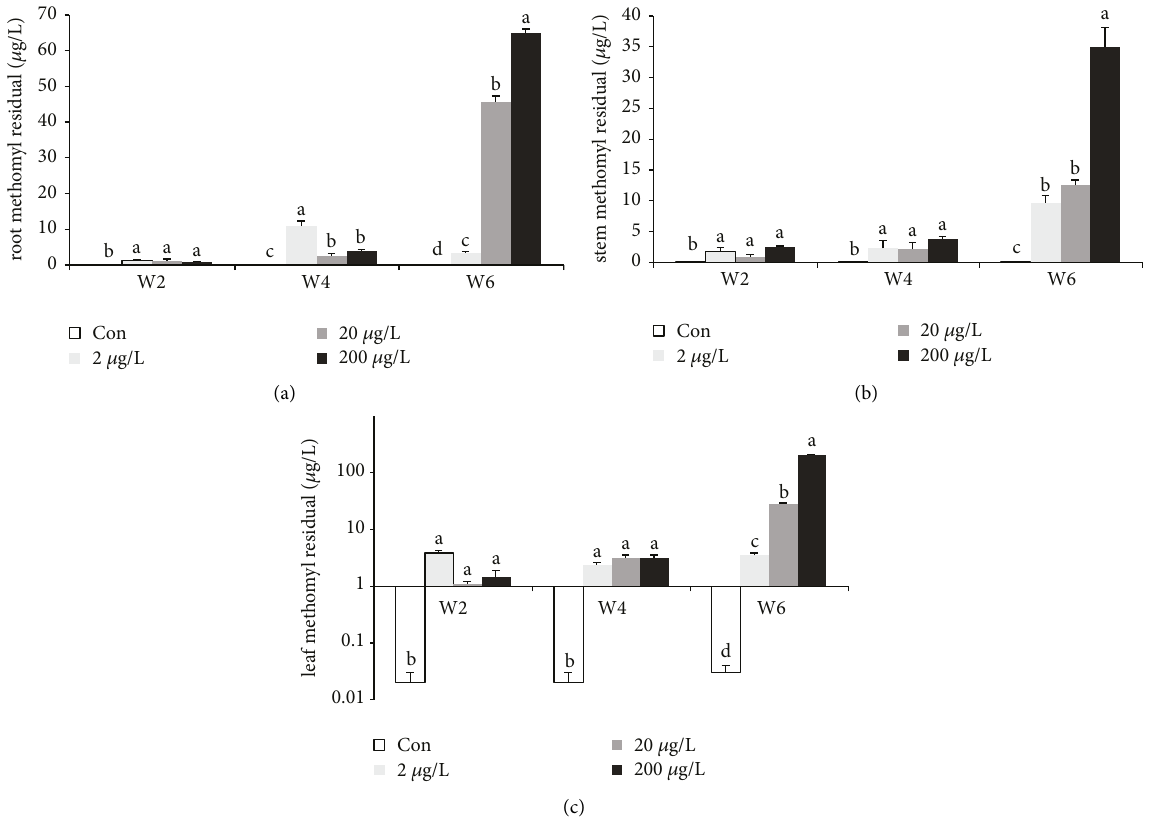
Figure 3: Combined view of MET residue in the root, stem, and leaves of the water spinach at w2, w4, and w6. Different subscripts in each group indicate significant difference. The treatment for 0, 2, 20, and 200 μ g/L MET in triplicate ( n � 12 total tanks for 4 groups and n � 15 individuals per tank in